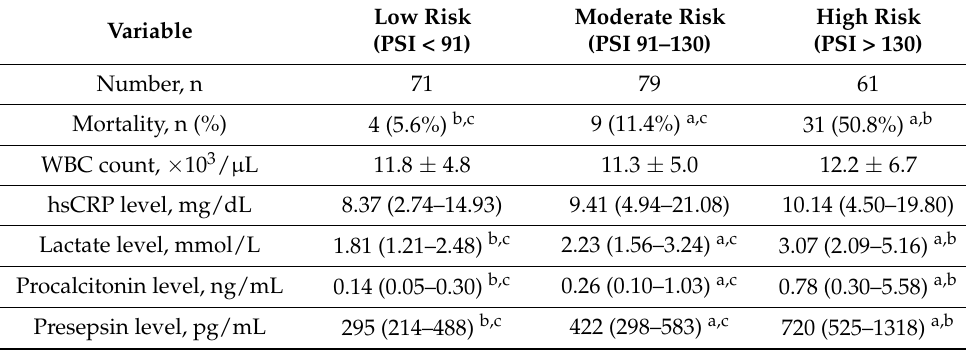
Table 2. Differences of laboratory results according to the risk